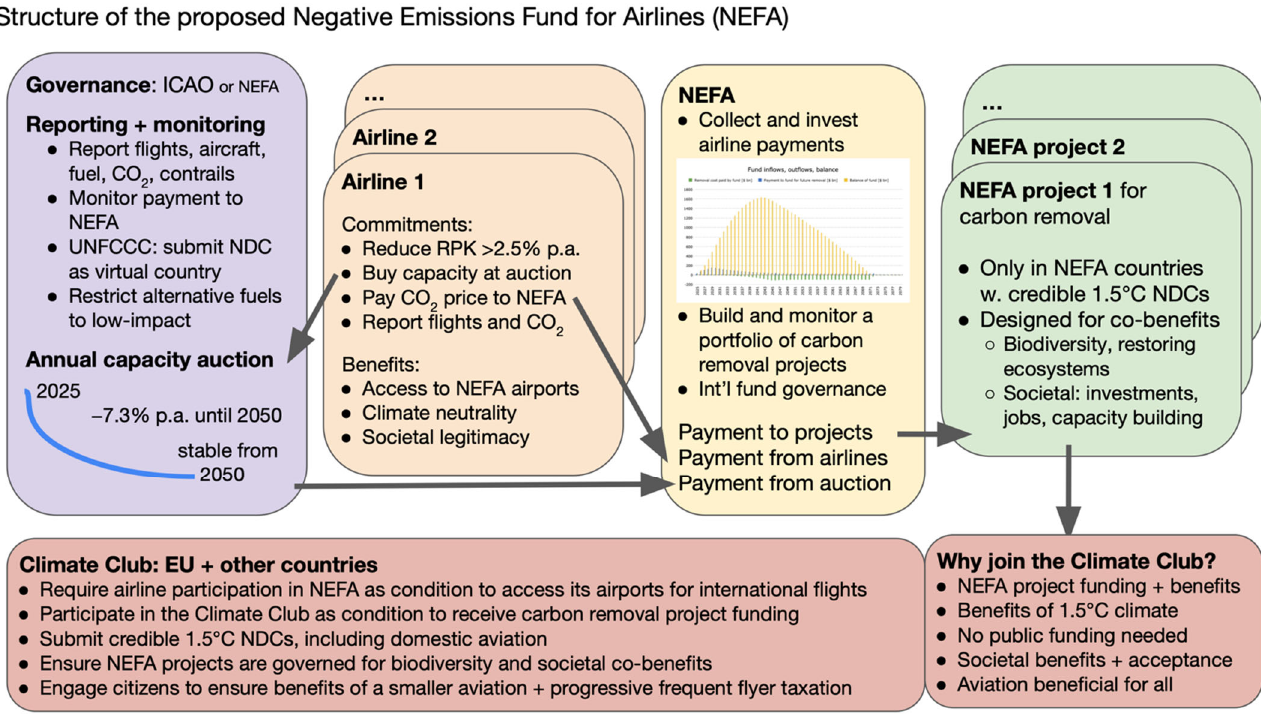
Figure 4. Links between the proposed governance structure, role of the fund, carbon removal projects, and benefits for countries, with arrows showing financial flows.